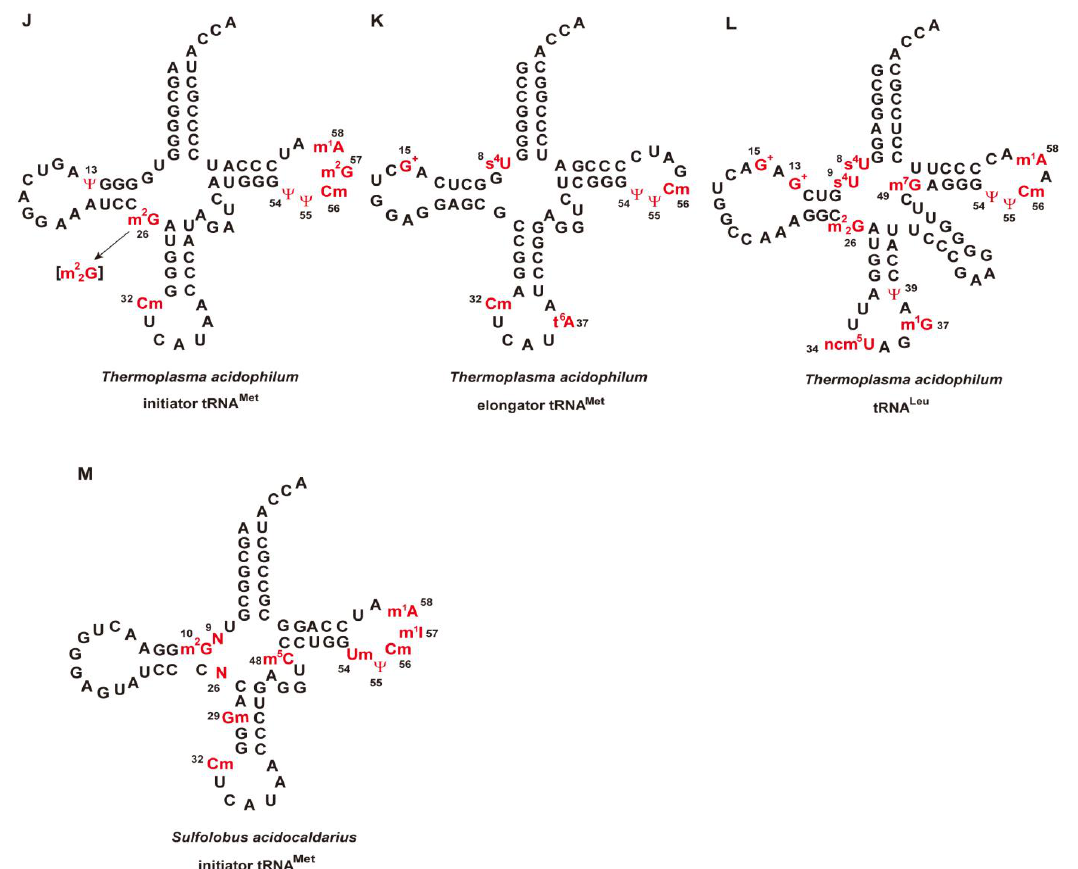
Figure 2. Sequences of tRNA from thermophiles. The modified nucleosides are indicated in red with their positions. Parentheses indicate that a portion of the modified nucleoside is further modified to its derivative. Abbreviations of modified nucleosides are given in Supplementary Table S1. ( A ) Geobacillus stearothermophilus tRNA Leu . ( B ) G. stearothermophilus tRNA Phe . ( C ) G. stearothermophilus tRNA Tyr . ( D ) G. stearothermophilus tRNA Val . ( E ) Aquifex aeolicus tRNA Cys . ( F ) Thermus thermophilus tRNA Asp . ( G ) T. thermophilus tRNA Ile . ( H ) T. thermophilus tRNA Met f 1. ( I ) T. thermophilus tRNA Phe . ( J ) Thermoplasma acidophilum initiator tRNA Met . ( K ) T. acidophilum elongator tRNA Met . ( L ) T. acidophilum tRNA Leu . ( M ) Sulfolobus acidocaldarius initiator tRNA Met In A. aeolicus tRNA Cys (E) the nucleotides shown in gray could not be determined and cyanoethylated tRNA Cys was not analyzed. Therefore, this tRNA may possess additional modifications (e.g., Ψ 39 , Ψ 55 and m 1 A58). Thermus thermophilus possesses two tRNA Met f species. The difference of tRNA Met f 2 is single G-C base pair, which is indicated in purple in (H). In S. acidocaldarius initiator tRNA Met (M), the nucleosides at positions 9 and 26 may be m 1 A